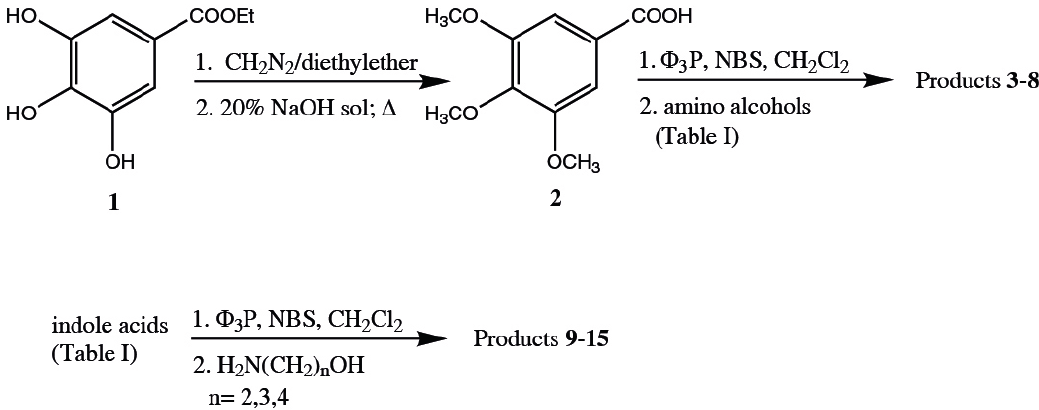
Figure 1 - Synthesis of hydroxyl amides 3-15